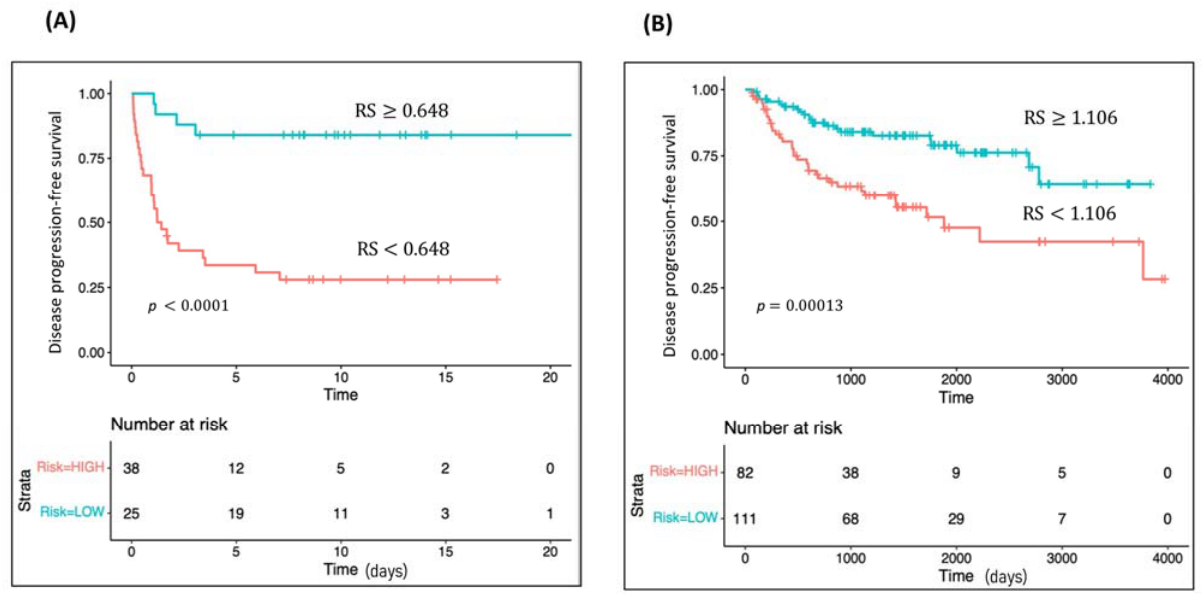
Figure 3. Performance of the combined classifier. Kaplan Meier survival analyses for tumor progression according to the combined classifier ( A ) in our cohort and ( B ) in the TCGA cohort.